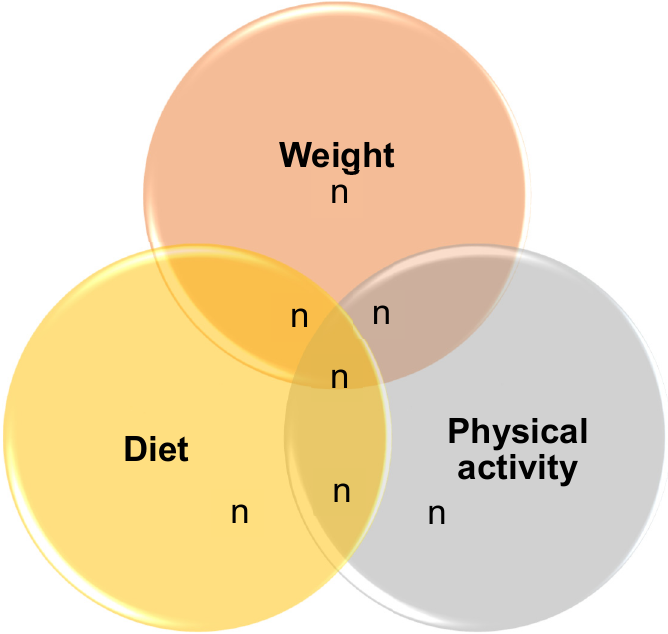
Figure 1. Number of articles on changes in weight, diet and physical activity.